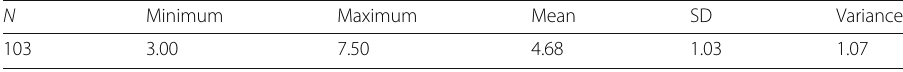
Table 3 Descriptive statistics of teachers ’ essay writing task